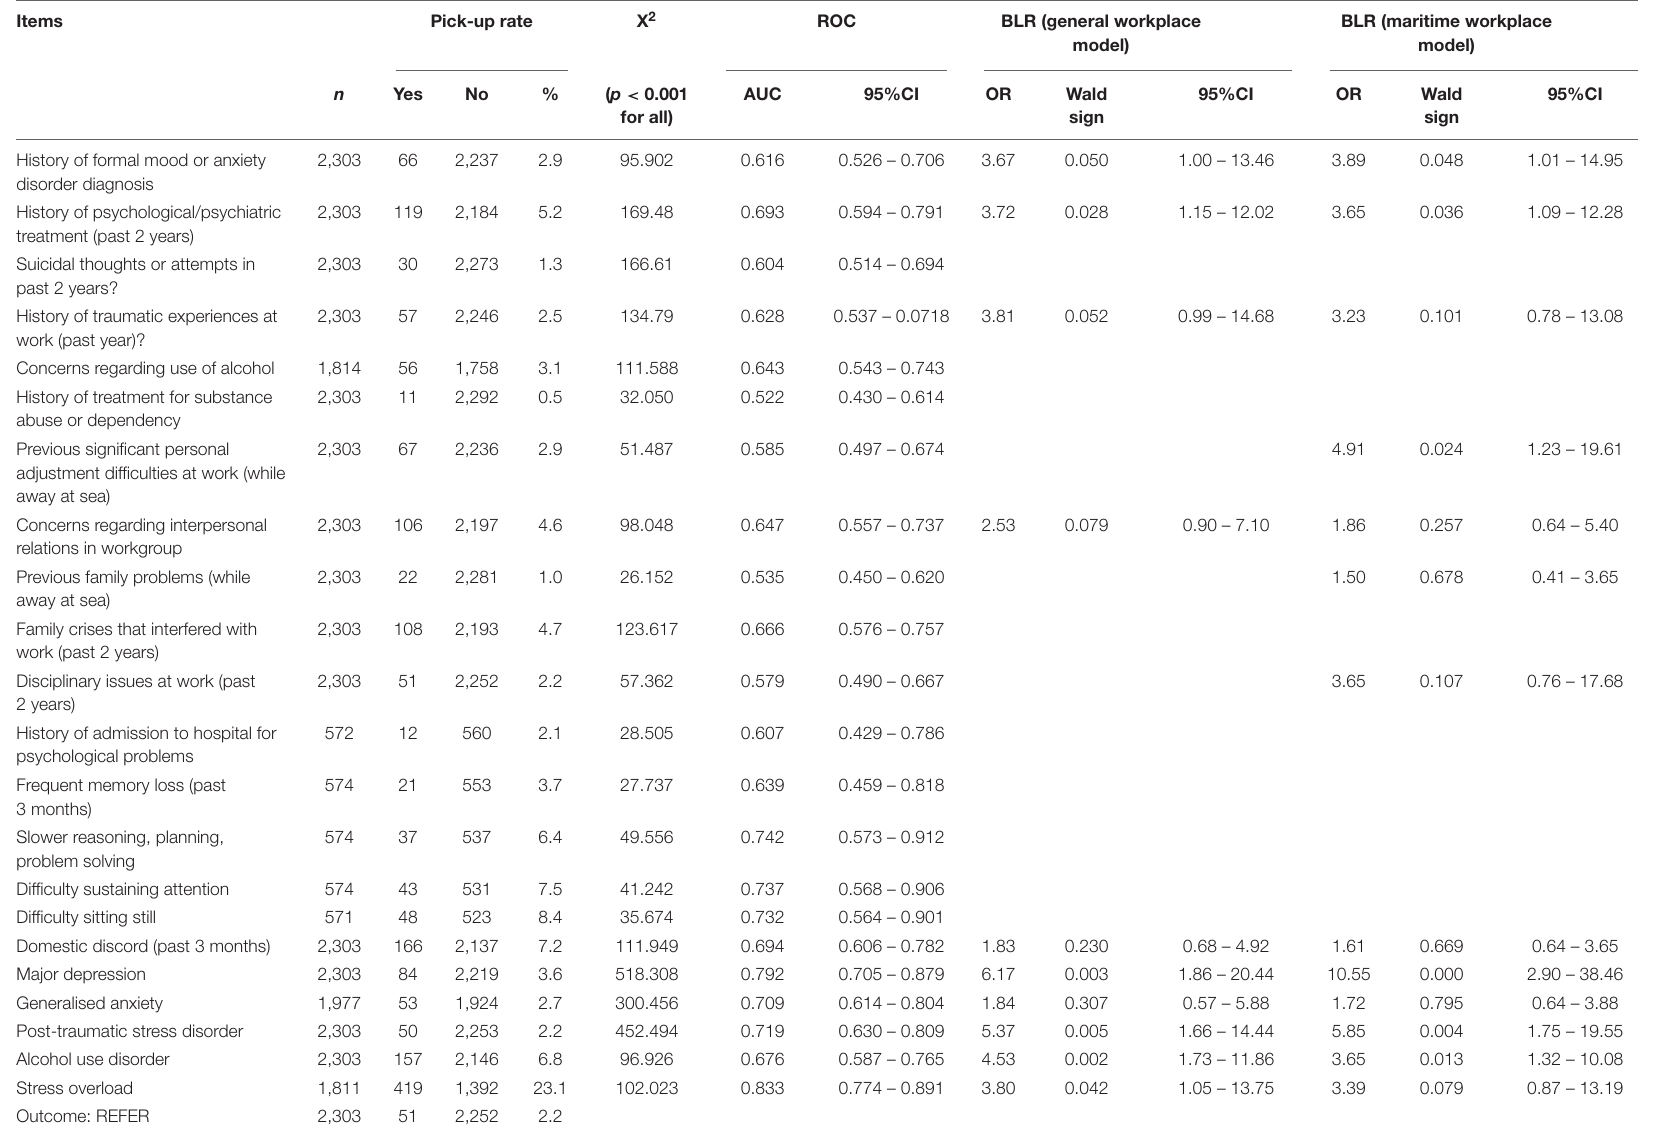
TABLE 2 | Association and prediction of individual markers to at-risk indicator.